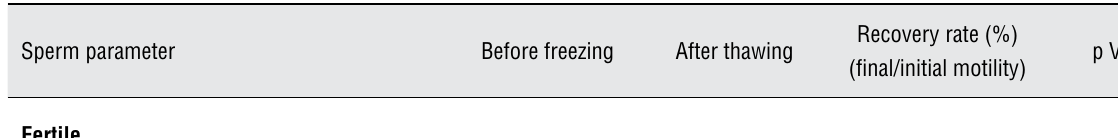
Table 4 – Recovery rates after cryopreservation in fertile and infertile men. Sperm parameter